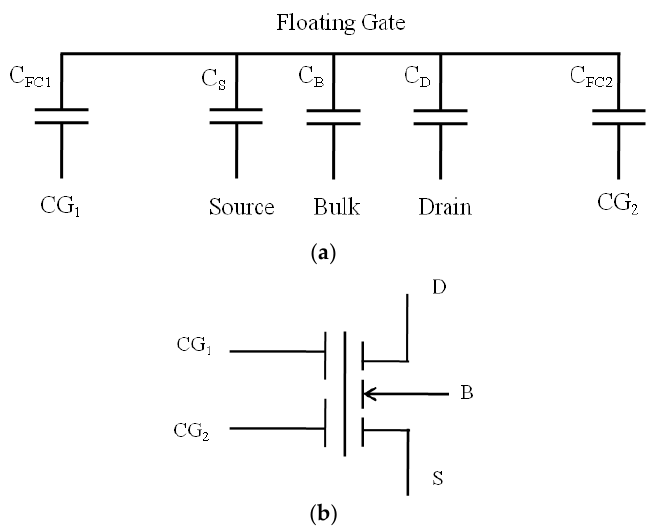
Figure 3. ( a ) The simple model of the equivalent schematic diagram of the proposed ANC device, where C FC ,C FC ,C S ,C D , and C B are the capacitors between the floating gate and the control gate CG 1 , the control gate CG 2 , the source, the drain, and the bulk region, respectively. ( b ) Symbols for the ANC device with five terminals.